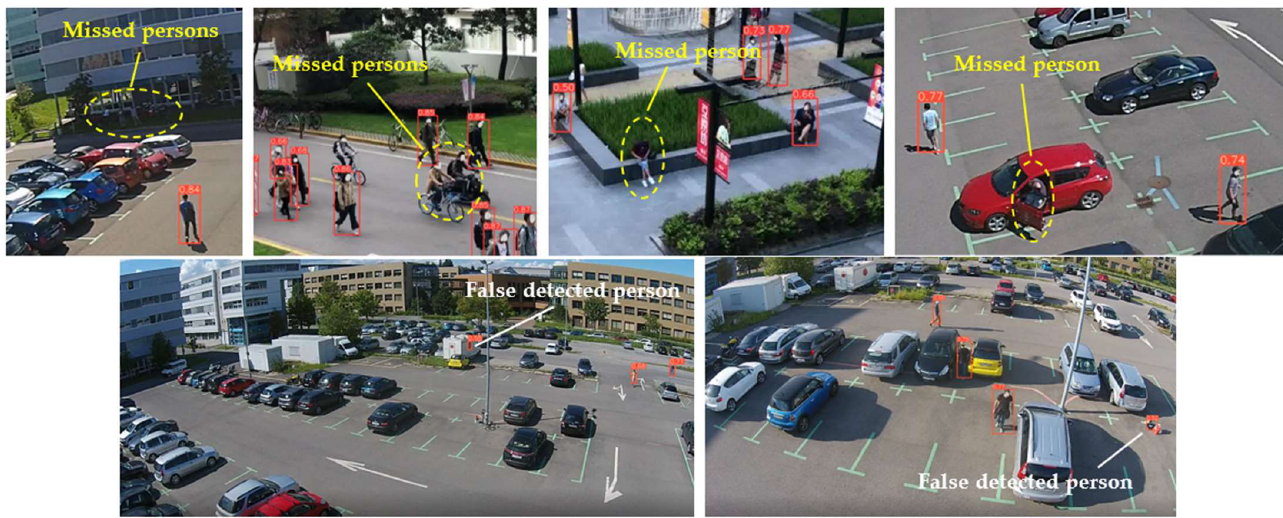
Figure 13. Observed FN entries (yellow ellipse with dashed line) and FP entries (white indications) during the person detection process applying the custom YOLOv5s.